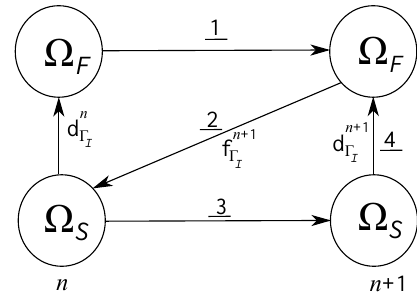
Figure 9. Blade planform.